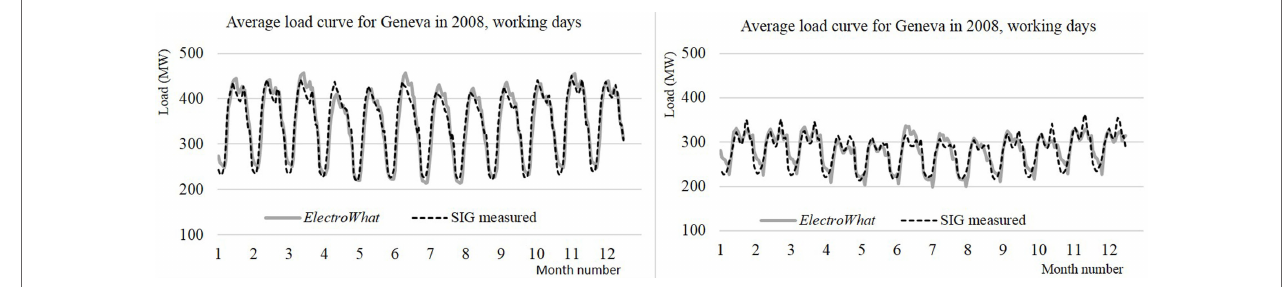
FIGURE 10 | Actual and simulated average hourly load curve from January (1) to December (12) 2008 for the Canton of Geneva.